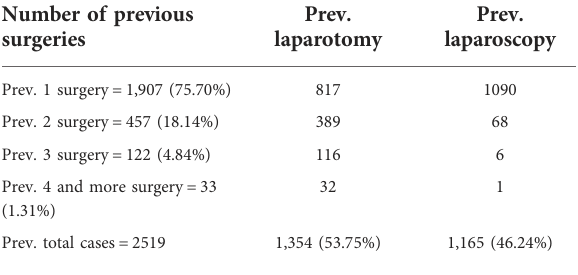
TABLE 3 Distribution of cases according to the number of surgeries in the past.